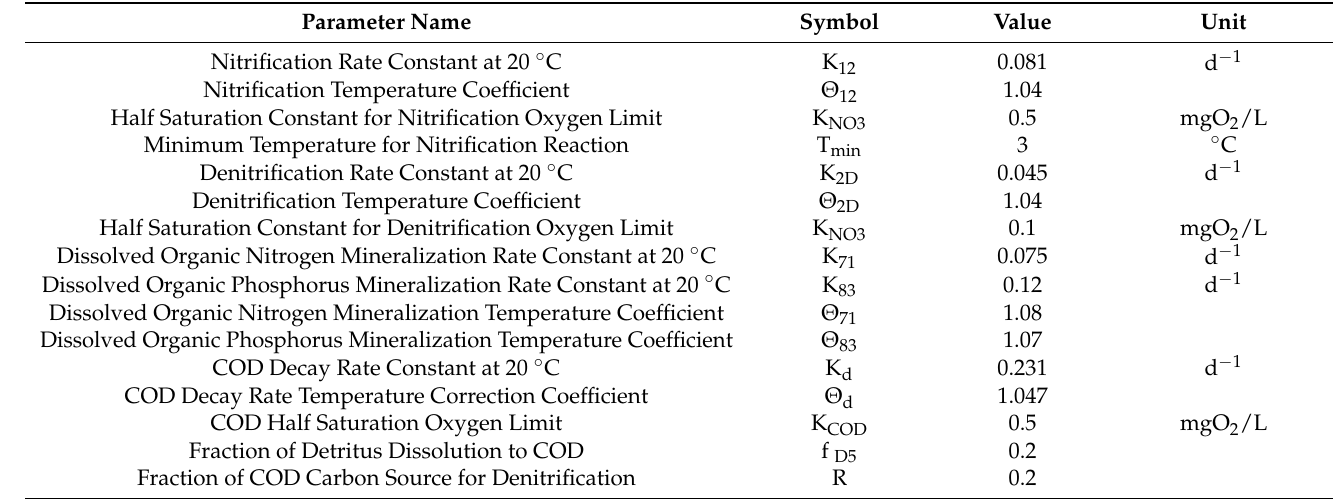
Table 11. Model parameter calibration results.